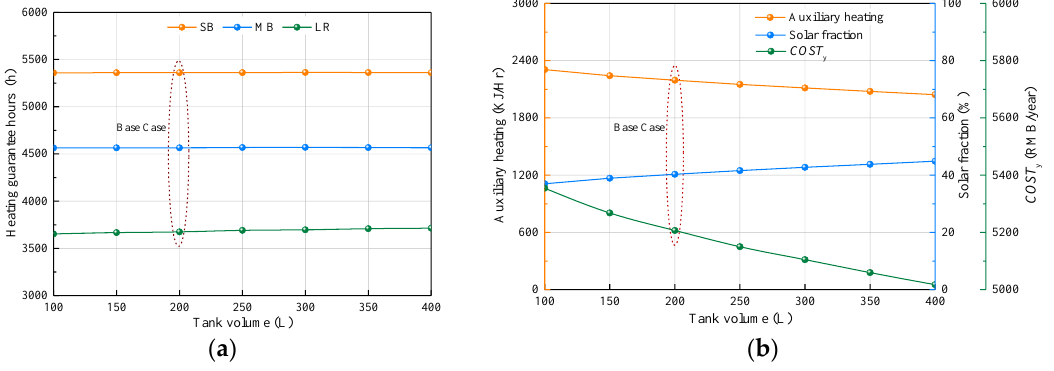
Figure 9. Optimized analysis of different tank volumes. ( a ) Heating effect; ( b ) system performance evaluation.